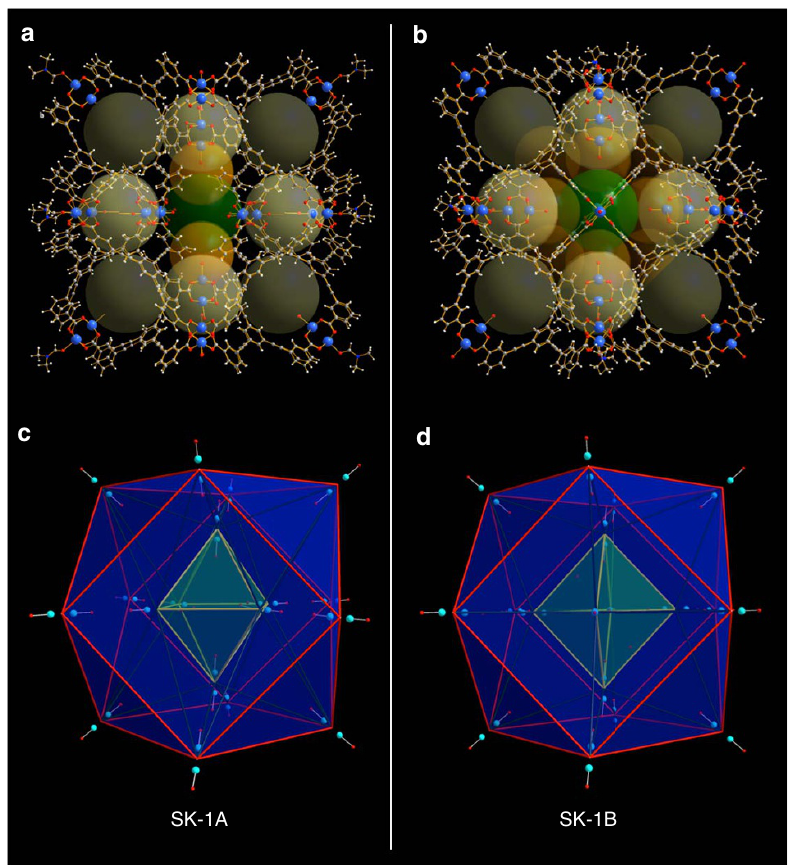
Figure 1 | Structure of SK-1. ( a , b ) Structures of the SK-1A and SK-1B. ( c , d ) Endohedral arrangement of Archimedean and Platonic bodies in SK-1A and SK-1B; inner octahedra are rotated in their basal planes by ca. 45 (cid:2) in SK-1A and SK-1B,